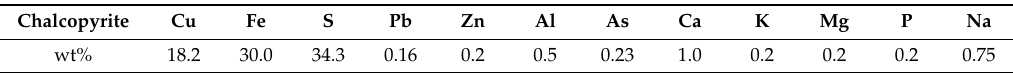
Figure 2. SEM images of the chalcopyrite-bearing ore at ( a ) ×1500 and ( b ) ×5300 magnification.